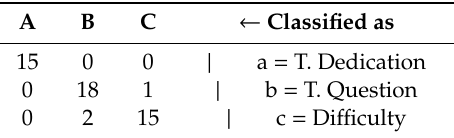
Table 2. Matrix of